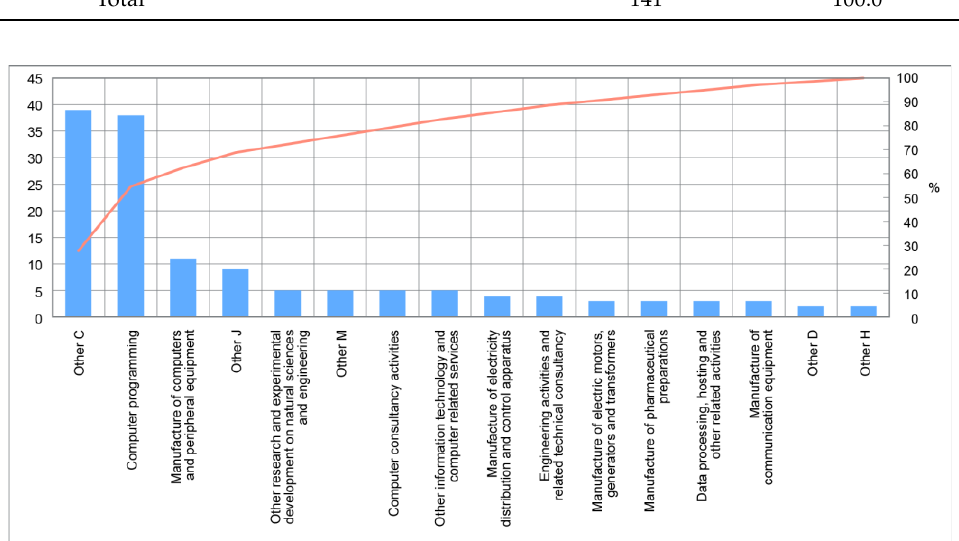
Figure 6. Distribution of I4.0 potential across classes of activity.